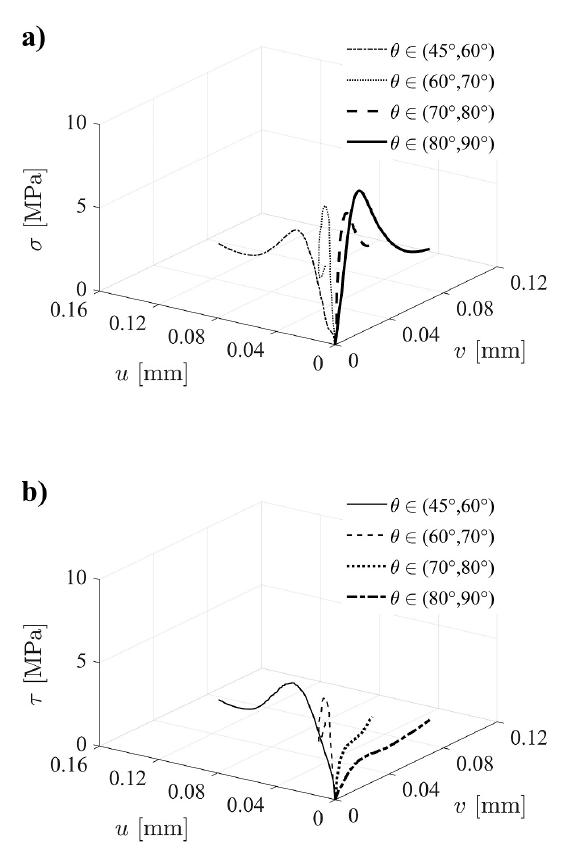
Figure 6. Mean cohesive laws distribution over the range of phase angles: ( a ) σ ( v , u ) ; ( b ) τ ( v , u ) . In more detail, Figure 7 plots the evolution of the several cohesive parameters as function of the global phase angle. The rising trend of the normal peak stresses (Figure 7a) and the decreasing tendency observed for the shear ones were approximated by linear functions. Extrapolating for 𝜃 = 90° in the linear fitted equation ( 𝜎 = 𝑓(𝜃) ) Figure 7a and for 𝜃 = 0° in the relation of Figure 7b provides an estimation of the local strengths under pure mode I and pure mode II, respectively. The obtained values point to 𝜎 (cid:3048) = 8.96 MPa and 𝜏 (cid:3048) = 16.56 MPa. These values compare well with the ones reported in [4] for the same wood species ( 𝜎 (cid:3048) = 7.93 MPa and 𝜏 (cid:3048) = 16.0 MPa), revealing that the followed procedure effectively captures these material parameters. The same strategy was followed for the evolution of the strain energy release rate components ( 𝐺 (cid:2893) and 𝐺 (cid:2893)(cid:2893) ) in function of 𝜃 . Considering the linear relationships obtained in Figures 7c,d, the critical fracture energies point to 𝐺 (cid:3010)(cid:3004) = 0.5 N/mm and 𝐺 (cid:3010)(cid:3010)(cid:3004) = 1.0 N/mm, respectively. In the mode I case, the obtained value is somewhat higher than expected, since a recent characterization of this wood species under mode I loading [35] pointed to values in the range of 0.3–0.4 N/mm. In contrast, the 𝐺 (cid:3010)(cid:3010)(cid:3004) value is in close agreement with recent pure mode II fracture characterization, which points to 𝐺 (cid:3010)(cid:3010)(cid:3004) = 0.97 N/mm [36].